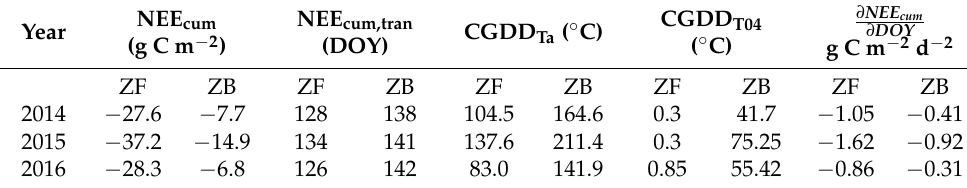
Table 5. Cumulative net ecosystem exchange of CO 2 (NEE cum ; g C m − 2 ), the day of year (DOY) of transition from NEE cum source to NEE cum sink (NEE cum,tran ; DOY), cumulative growing degree days of air temperature (CGDD Ta ; ◦ C) corresponding to NEE cum,tran , cumulative growing degree days of surface soil temperature (CGDD T04 ; ◦ C) corresponding to NEE cum,tran , and mean slope ( ∂ NEE cum m − 2 d − 2 ) after reading peak of NEE cum for ZF and ZB for the period DOY 99–155 in